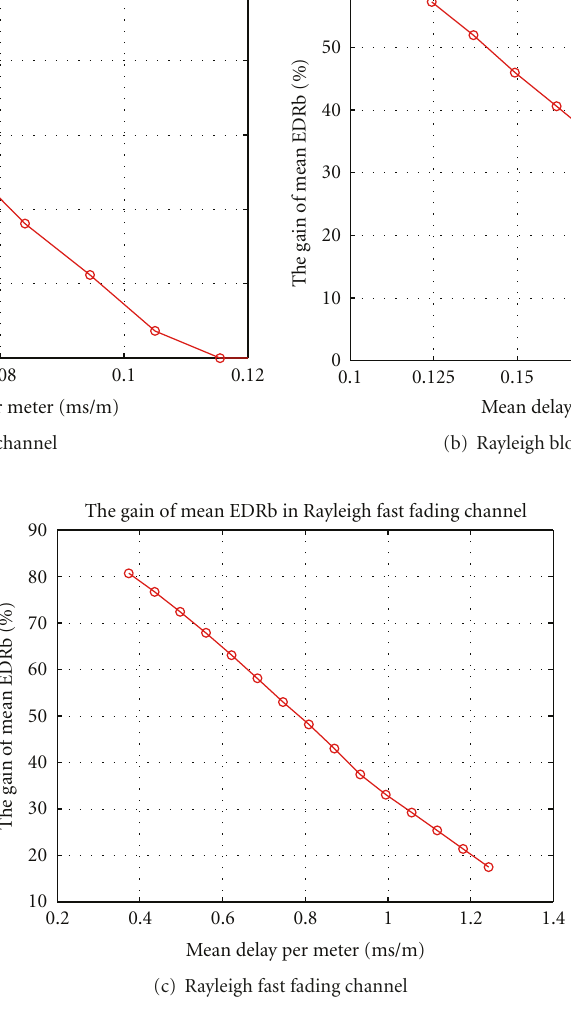
Figure 5: Comparison between traditional P2P communication and opportunistic